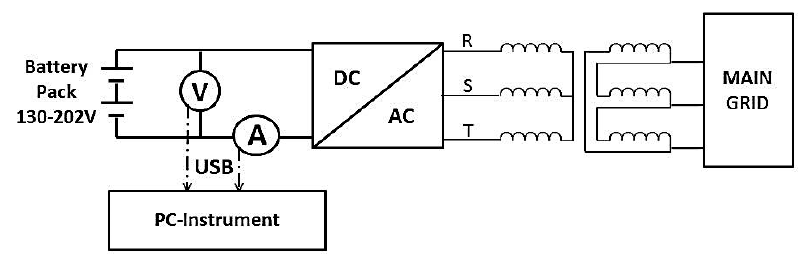
system was connected to the network via a DC/AC inverter and a step-up transformer (see Figure 20)